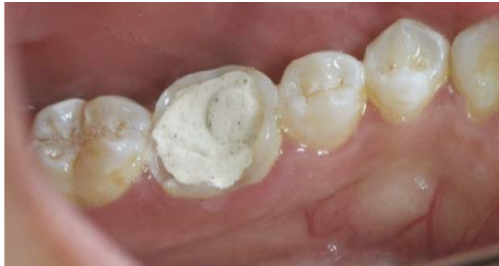
Figure 1: Clinical condition of tooth #46 with extensive glass ionomer cement restoration.